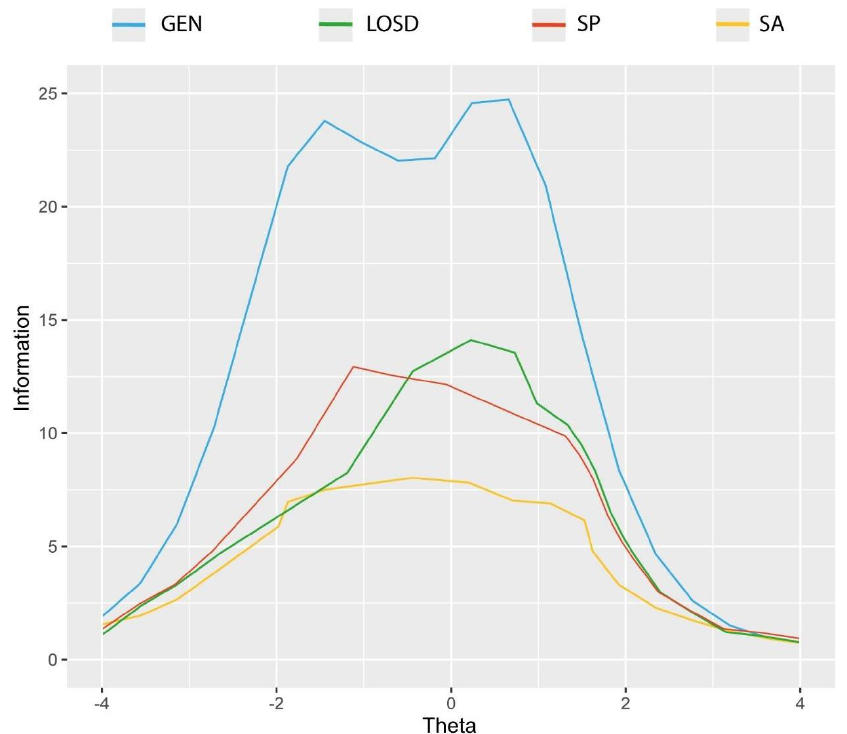
Figure 2. The Gratitude Resentment and Appreciation Test-Revised Short (GRAT-RS): Test information function (MIRT-grade response model) ( n = 537). GEN: general factor; LOSD: lack of a sense of deprivation specific factor; SP: simple pleasures specific factor; SA: social appreciation specific factor.